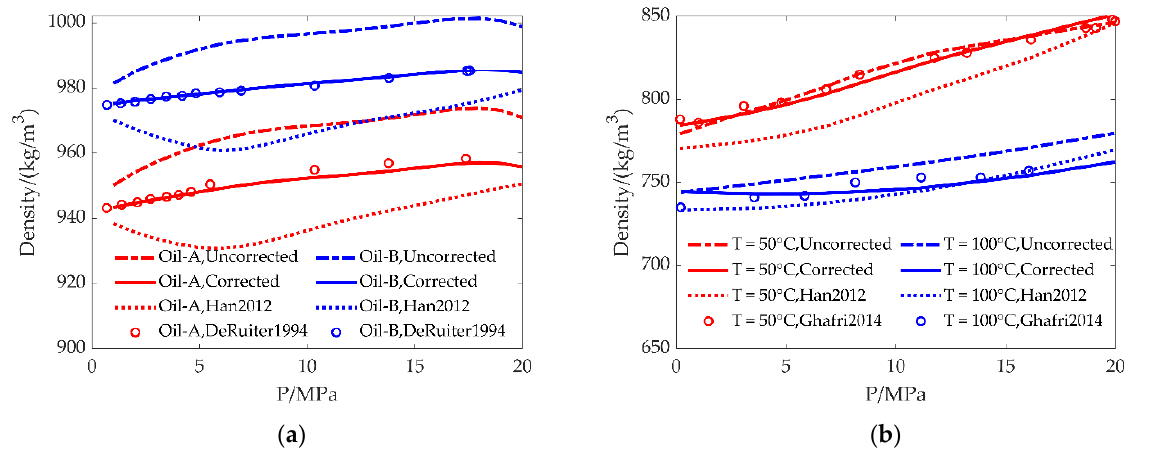
Figure 7. Density model validation of live oil in different oil samples: ( a ) oil sample from DeRuiter [33] [M2] ; ( b ) oil sample from Al Ghafri [34] [M3] .